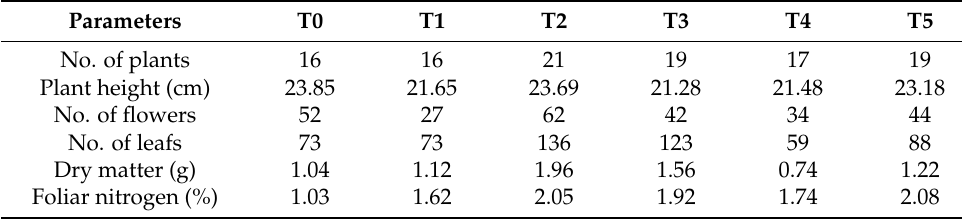
Table 3. Effects of biofertilization on Coriander sativum . Plant